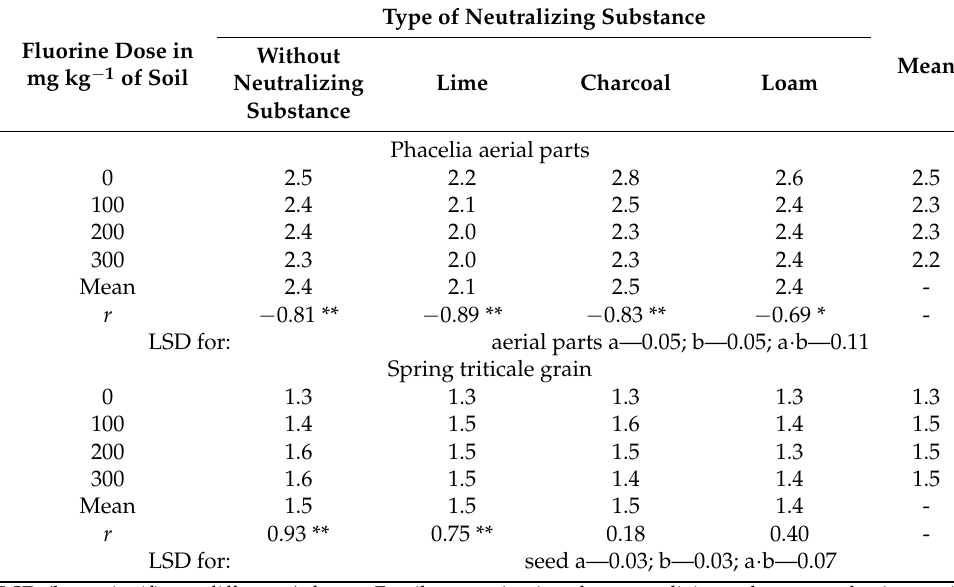
Table 5. Sulphur content in phacelia aerial parts and spring triticale seed, in g S kg − 1